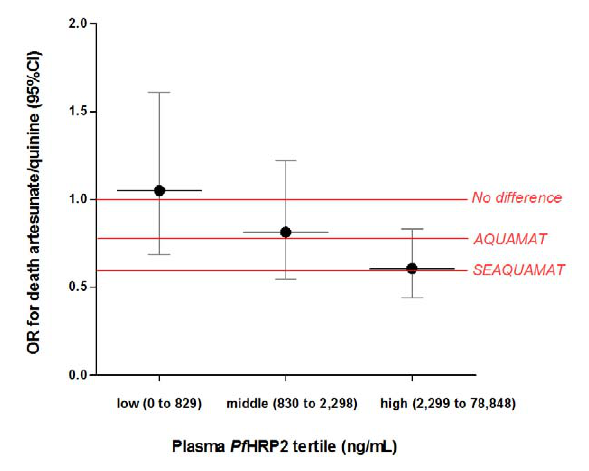
Figure 3. Treatment effect, as odds ratio for death, of artesunate versus quinine. Effect is measured according to plasma Pf HRP2 tertiles and compared to the overall treatment effect observed in the AQUAMAT trial [17] in 5,425 African children and in the similar SEAQUAMAT trial [32] in 1,461 (predominantly) adults in Asia.